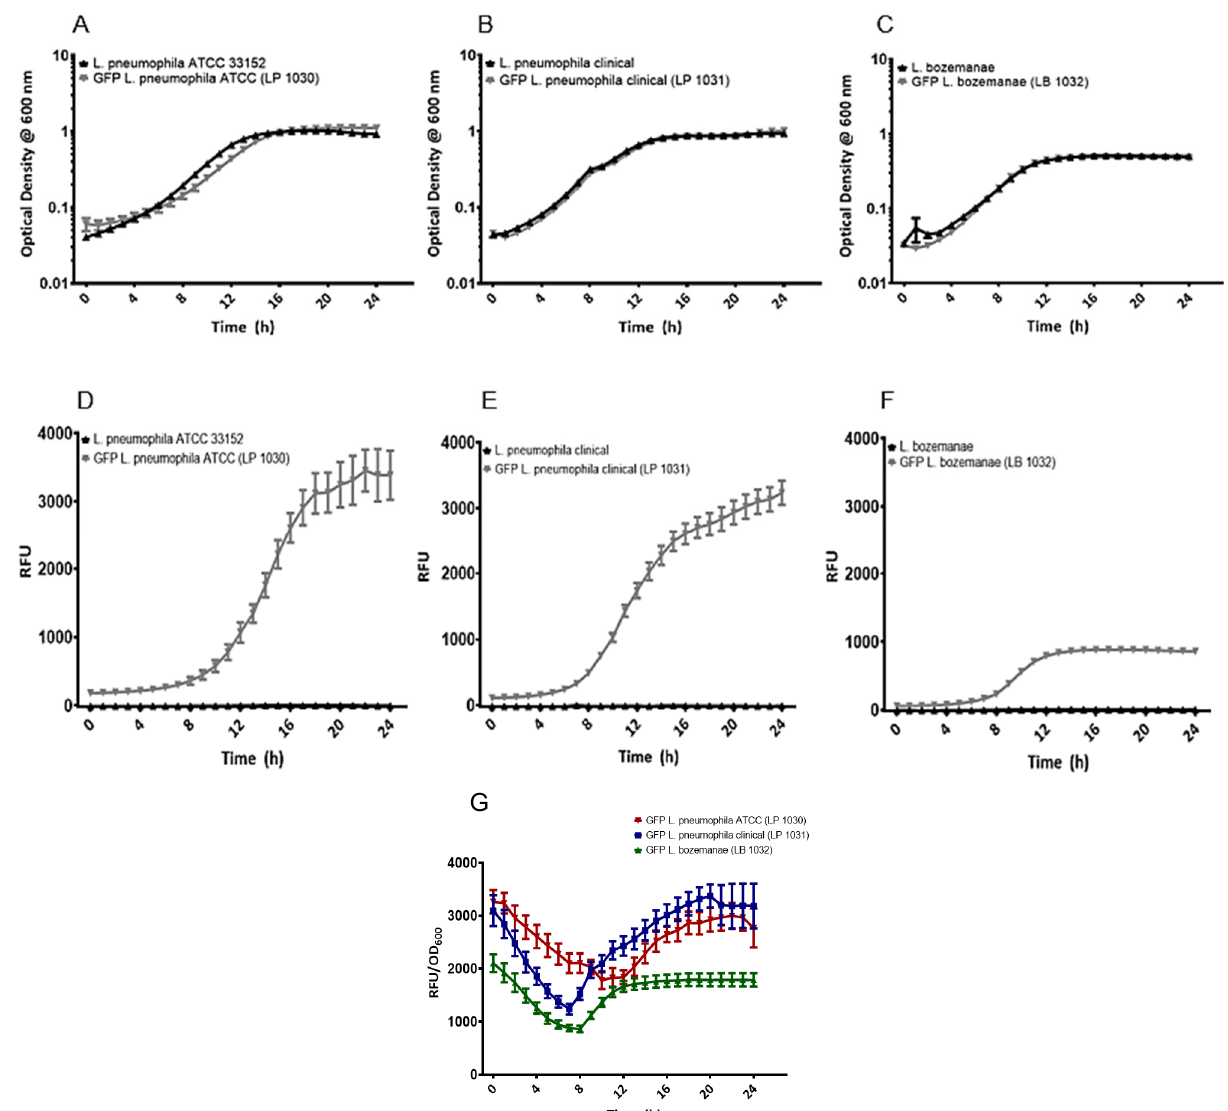
Figure 2. In vitro growth curves and relative fluorescence for the GFP-tagged Legionella and parental strains. All Legionella isolates were incubated in BYE broth with shaking in an automated microplate reader for 24 h where OD 600 ( A – C ), RFU ( D – F ), and RFU/OD 600 ( G ) were measured every hour. For panels A – F , the parental strains are displayed in black, while the GFP-expressing strains are shown in gray. For panel G, the GFP-expressing L. pneumophila ATCC and L. pneumophila clinical isolate are shown in red and blue, respectively, while the GFP-expressing L. bozemanae is in green. All experiments were performed in triplicate and data represent the mean ± standard errors; ATCC, American Type Culture Collection; BYE, Buffered Yeast Extract; GFP, green fluorescent protein; OD 600, optical density at 600 nm; RFU, relative fluorescent units.